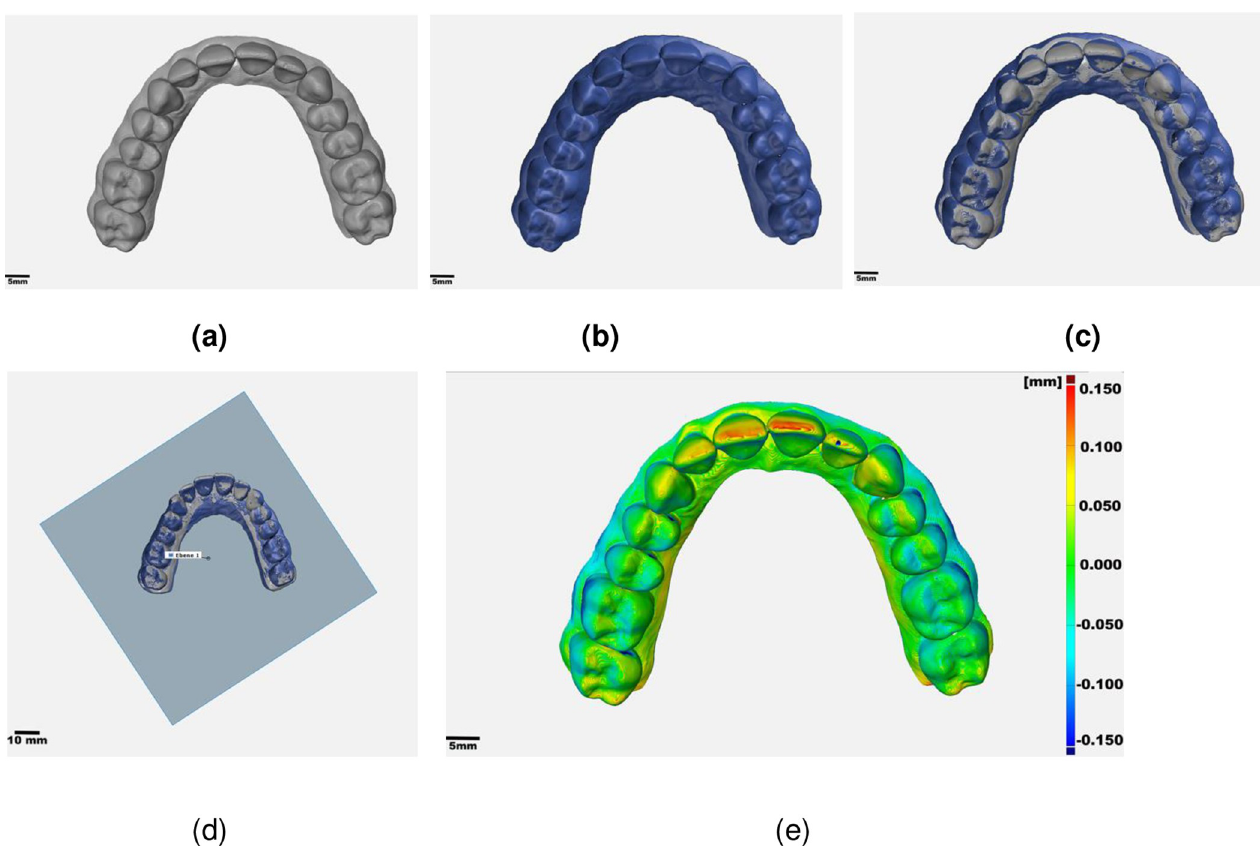
Fig 5. Digital processing of the data sets in GOM Inspect 2020. (a) reference cast; (b) test cast; (c) Best-fit alignment: superimposition of reference and test cast; (d) principle of trimming of all test casts; (e) surface comparison [Scale ± 150 μ m].